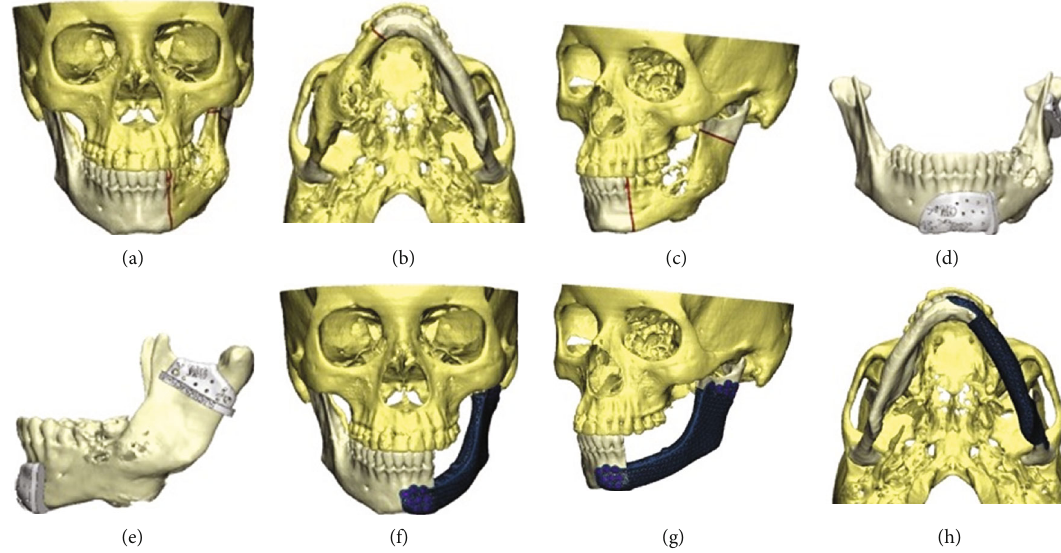
Figure 3: (a – e) Three-dimensional simulation cutting guides. (f – h) Simulation of the custom implant in porous (Figures 3(f) – 3(h)). The titanium plate was designed to allow the placement of dental implants ( 4 : 1 mm × 10 mm ) at the same time. The designed titanium plate (thickness of 12 mm) was printed with medial grade powder (constituted of porous grade 2 titanium).